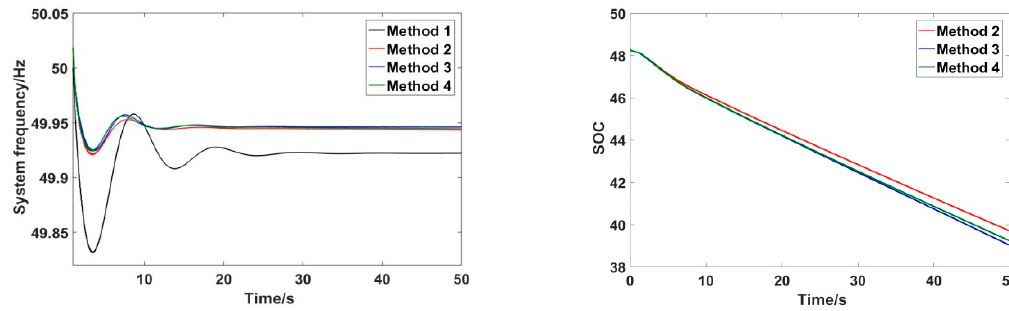
Figure 11. Results of 16 MW step load disturbance.